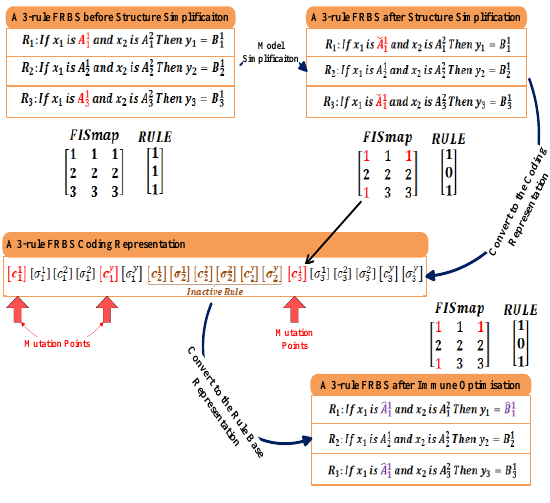
Fig. 6. If a link is set up, no missed mutation points are induced; inactive rules are not actually deleted but marked so that it will not participate in any computations